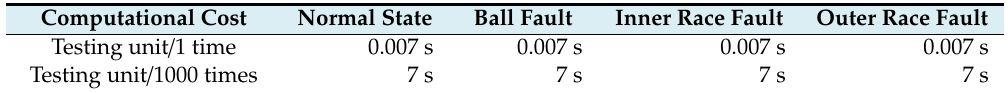
Table 5. Computational cost of four di ff erent